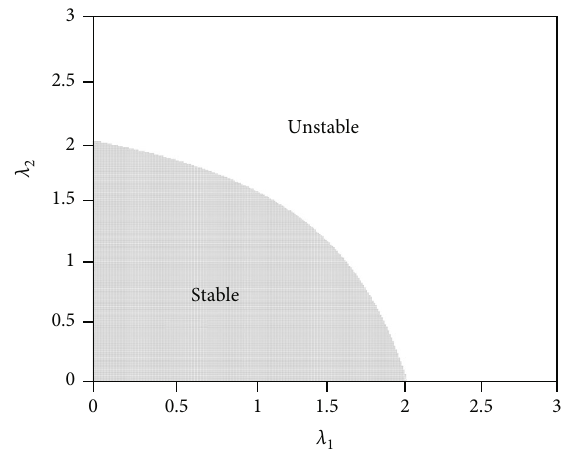
Figure 2: Stable area of system (23).